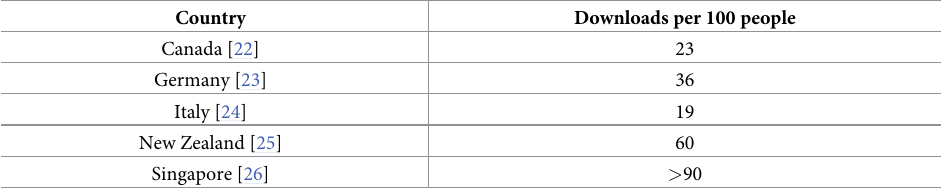
Table 1. Exposure notification app download rates in selected countries based on official